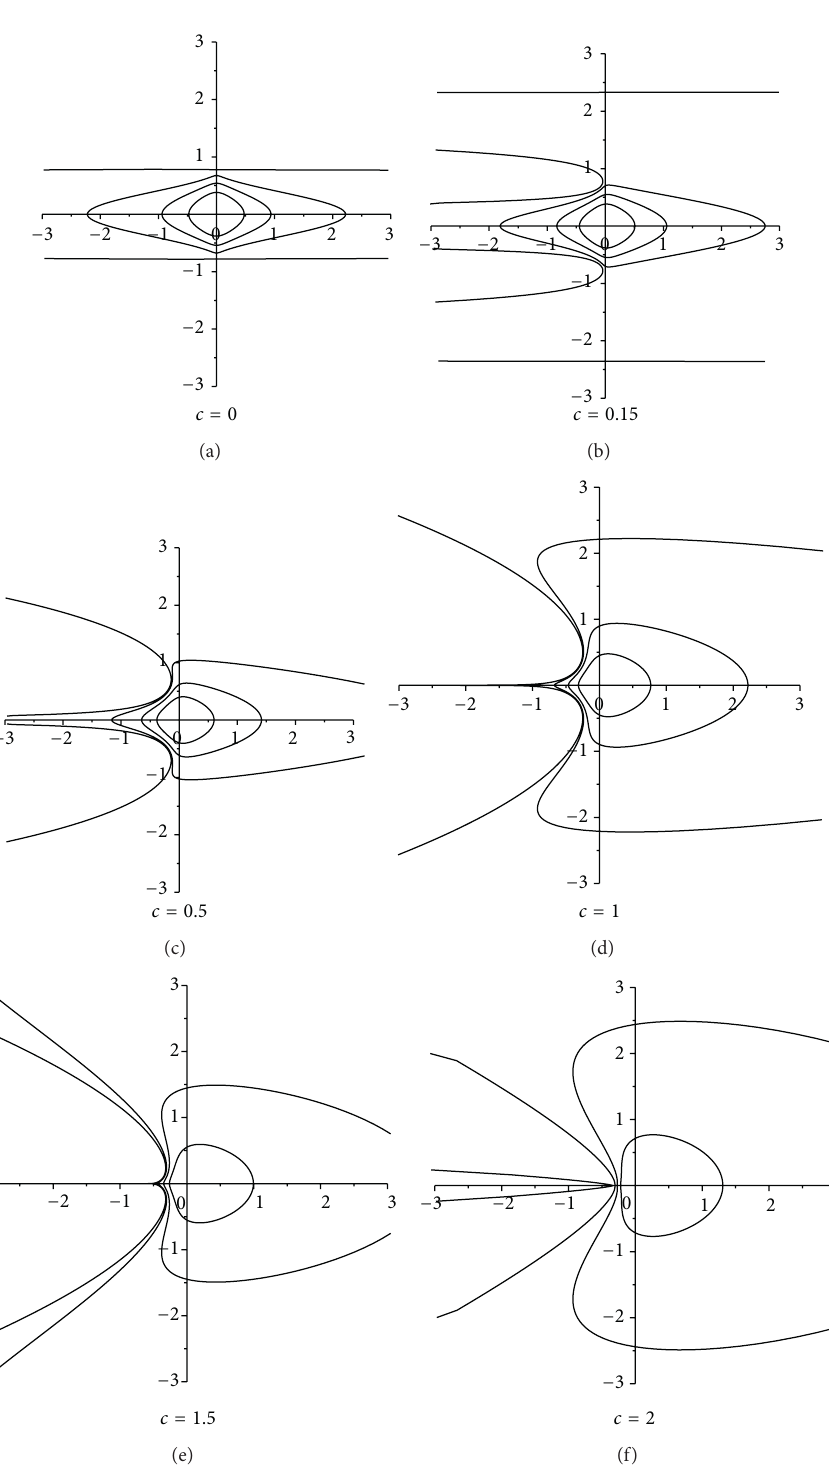
Figure 1: Images of 𝑓 𝑐 (|𝑧| = 𝑟) , 𝑟 = 0.4 , 0.6 , 0.8 , and 0.9999